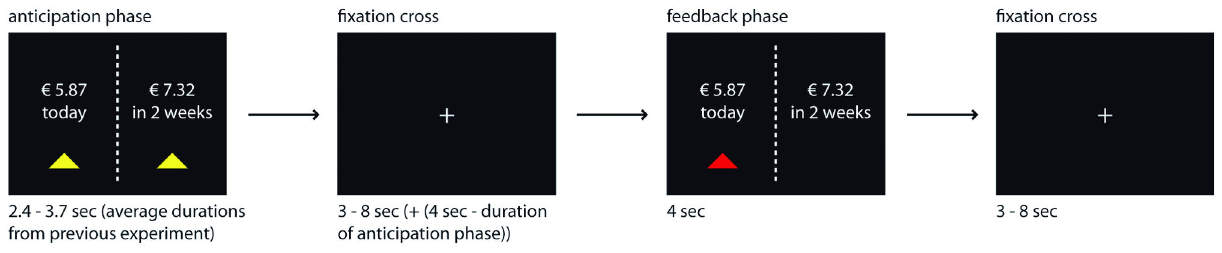
Figure 1. Paradigm: Choices were presented on a screen with the smaller, sooner reward always presented on the left side. After the subsequent presentation of a fixation cross (inter-trial interval), participants received feedback about the choice that was made by the decision